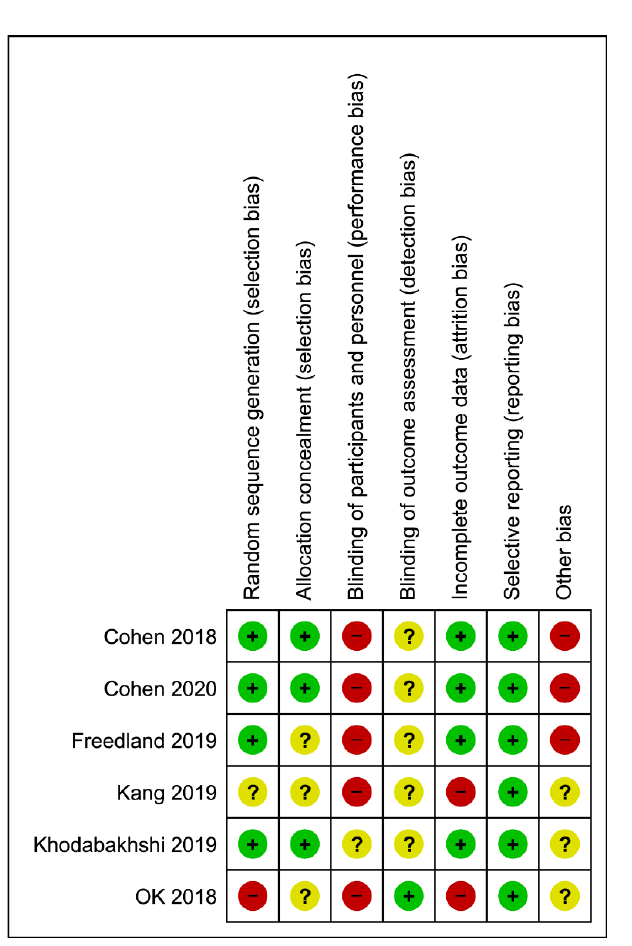
Figure 2. Assessment of risk of bias of the studies in the meta ‐